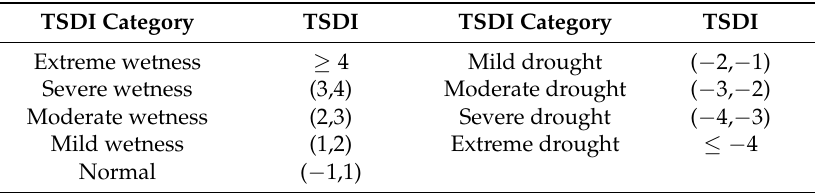
Table 1. Severity classification of TSDI drought and wetness.